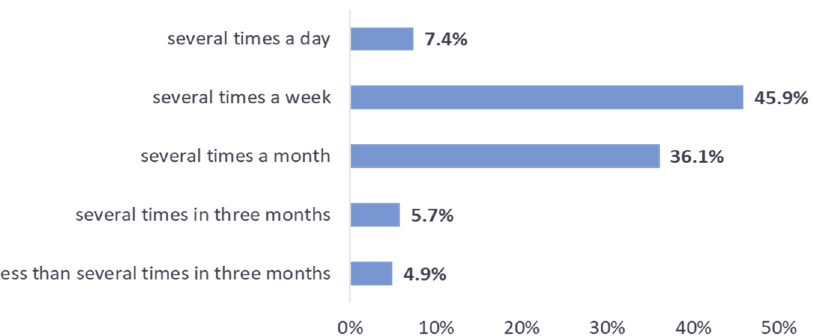
Figure 7. The willingness to receive several INFOBot questions in a given amount of